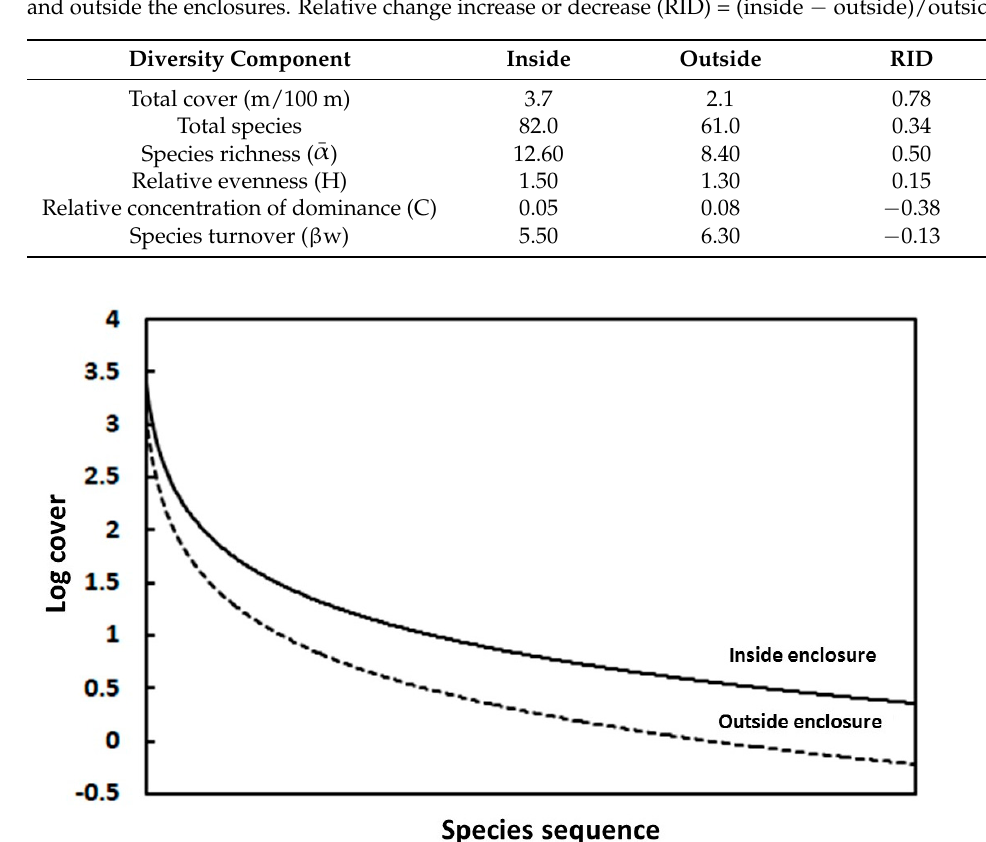
Diversity 2021 , 13 , 113 Figure 2. Logarithmic trend line of the species cover sequence inside and outside the enclosures.